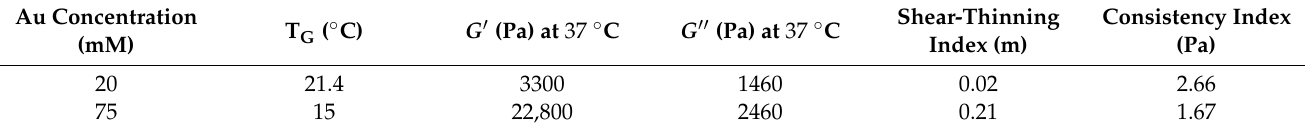
Table 1. Rheological parameters of the examined thermosensitive and electroconductive hydrogels. Au Concentration